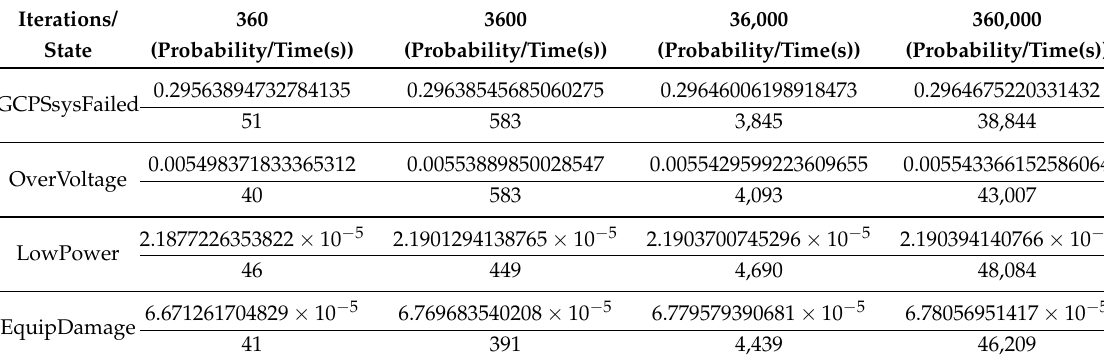
Table 3. Effects of time resolution on probabilistic results and calculation